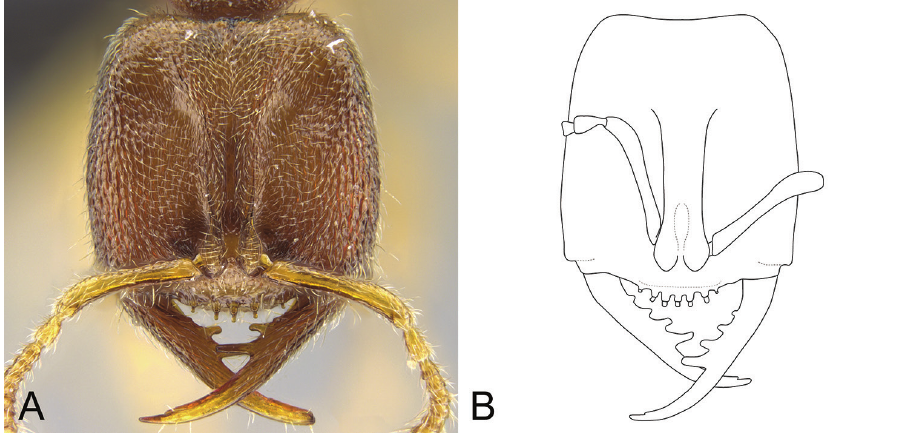
Figure 7. Stigmatomma scrobiceps and S. crypticum . A Holotype of S. scrobiceps (CASENT0339957); worker; full-face view. Image by Michele Esposito; available at AntWeb.org B Stigmatomma crypticum ; worker; full-face view. Illustration by FAE.